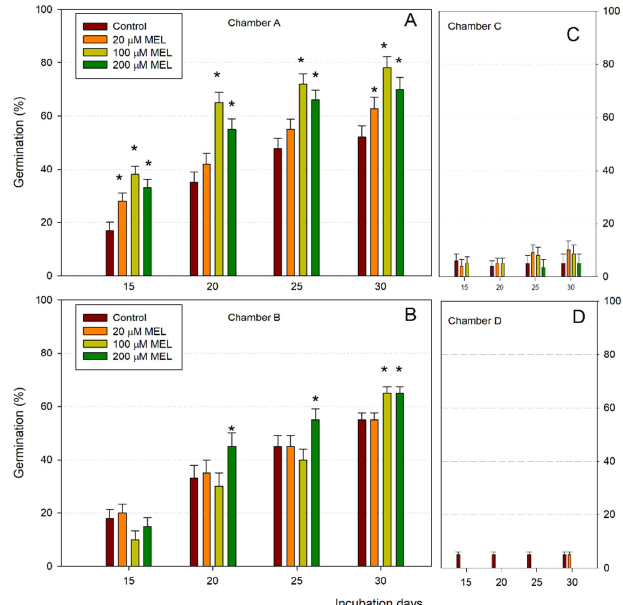
Figure 1. Germination rates (%) of almond seeds primed with melatonin (MEL) at different concen- trations after 30 days at 10 °C under 16:8h photoperiod ( A ) and in darkness ( B ), and at 22 °C under 16:8h photoperiod ( C ) and in darkness ( D ). Each bar represents the mean value ( n = 36) ± SE obtained for each concentration used of three repeated experiments. Asterisks indicate significant differences with the control of that day based on a Duncan test with a significance level of p < 0.05.